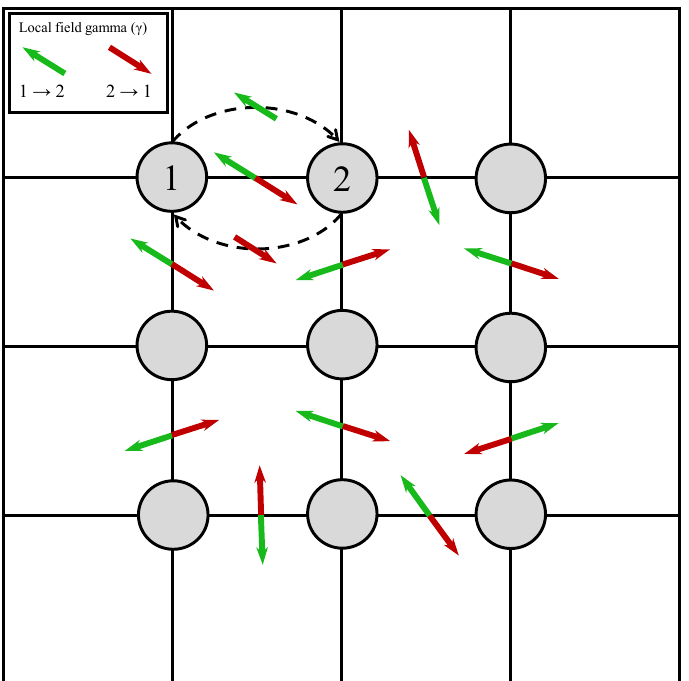
Figure 4. (Color online) Edge model of local fields. A spin rotates a set amount γ about a random direction (green arrows) when hopping to a site (e.g., a hop from Site 1 to Site 2). The return hop (e.g., a hop from Site 2 to Site 1) rotates through the opposite direction (red arrows) an amount γ . Therefore, the net rotation for a hopping sequence 1 → 2 → 1 is zero.